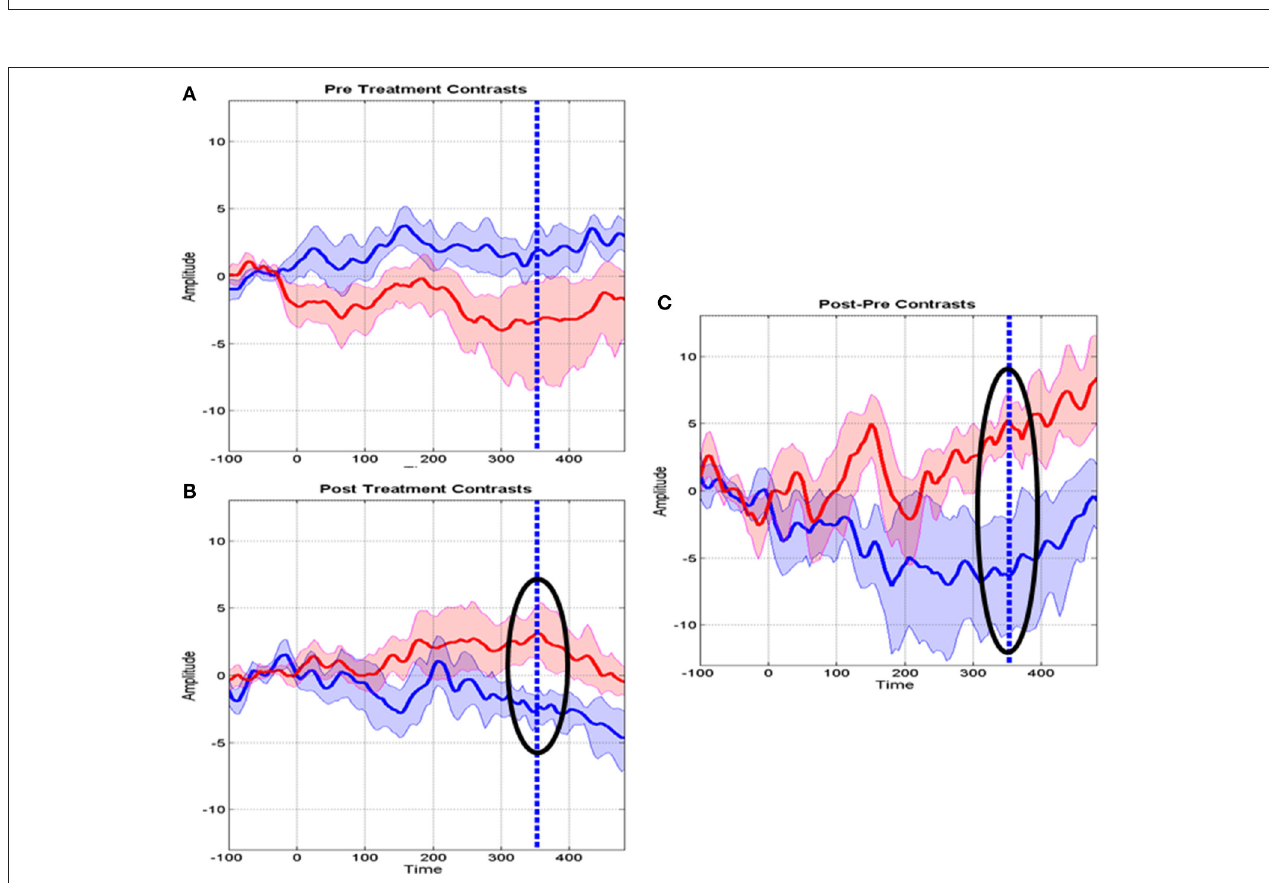
FIGURE 5 | Means and standard deviations of mismatch responses (MMR) at the Fz derivation. (A) Baseline MMR for the Control (blue) and MT groups (red). (B) Post-treatment MMR for the control and MT groups. Highlighted with a circle is the interval where the t tests survived correction for multiple comparisons. The dashed line indicates maximum significance. (C) Post-Baseline treatment MMR. Circles and dashed lines as in (B) .